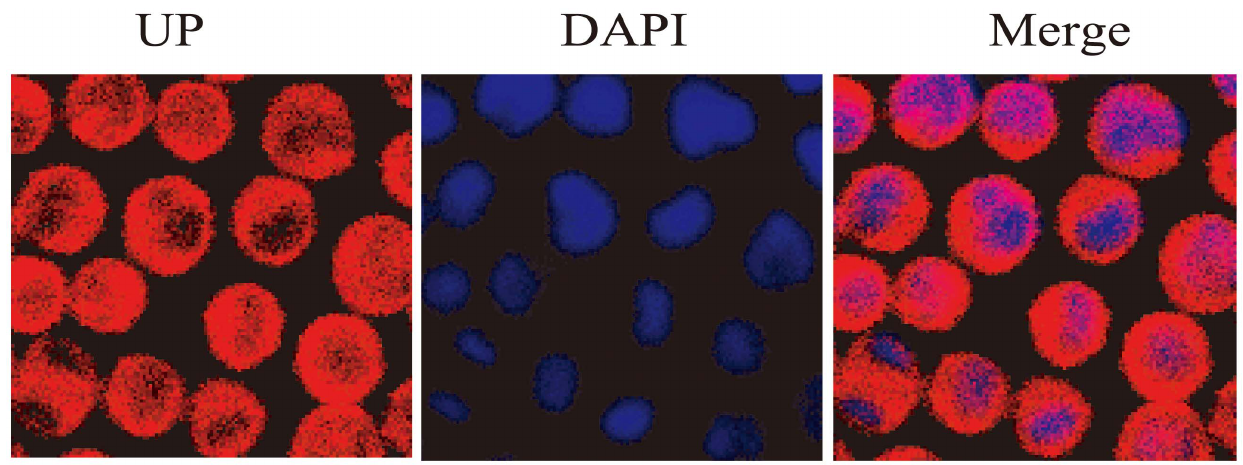
Figure 4. Confocal fluorescence images of P388 cells incubated with 0.05 m M UP for 1 h. The blue represents the nucleus staining and the red represents